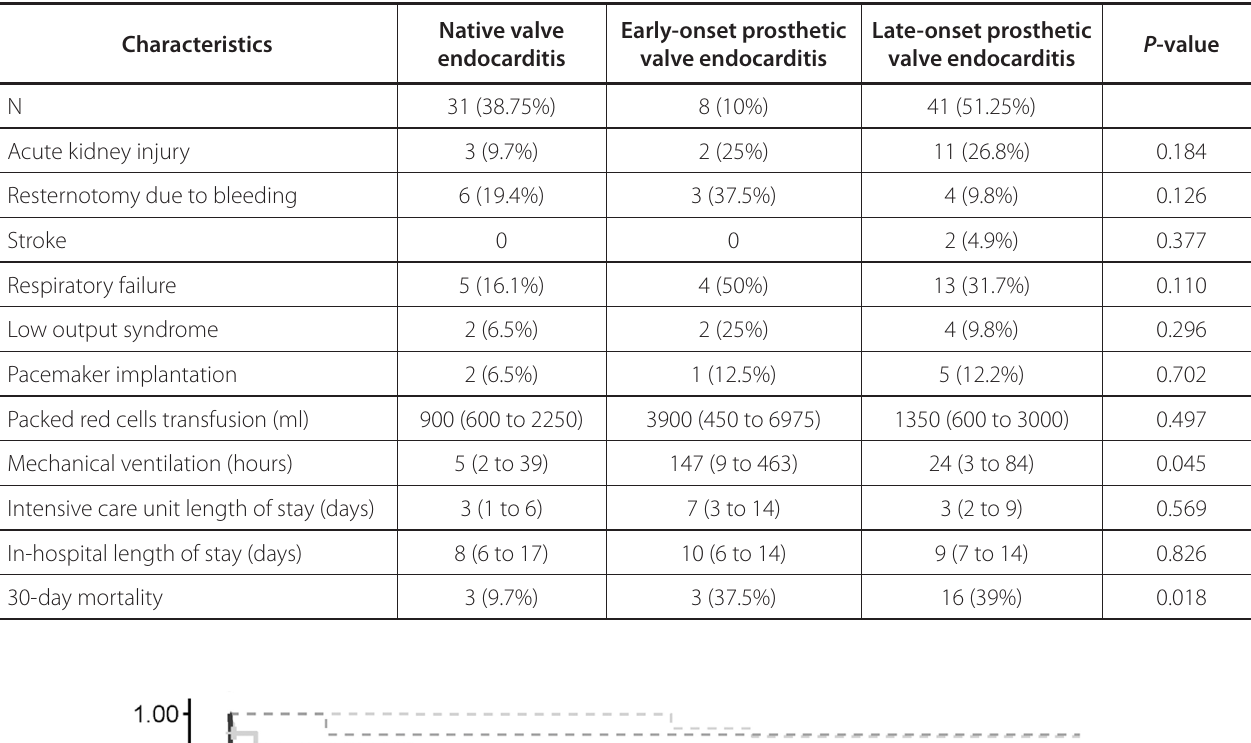
Table 4 . Postoperative characteristics.